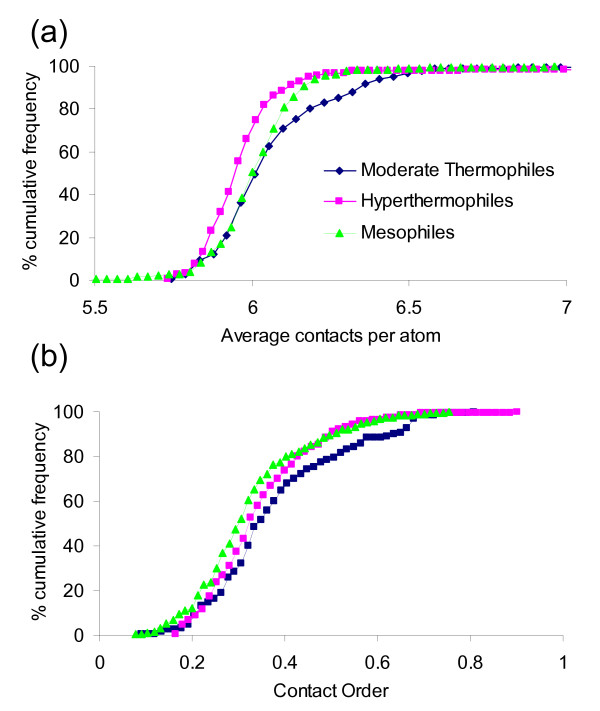
Separation by degree of compactness. (a) Packing calculated with the average number of contacts per atom. (b) Packing calculated using contact order [67].